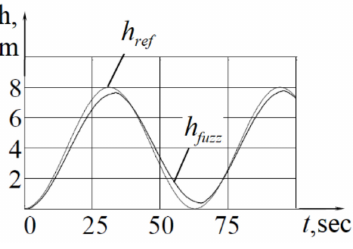
Figure 9. Control of the vertical movement of the AUV with a harmonic input signal: h ref is a graph of the depth; h fuzz —control signal.